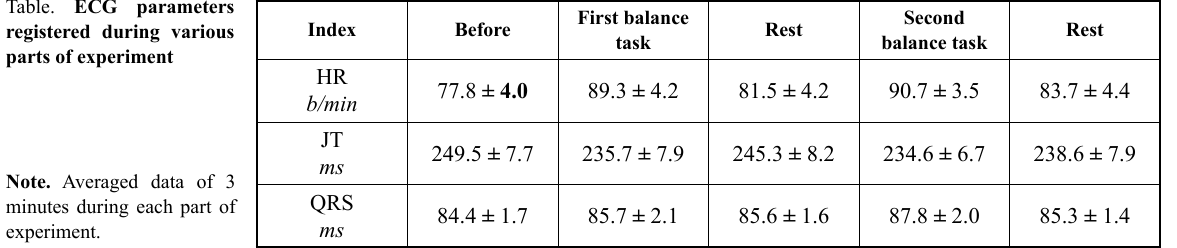
registered during various parts of experiment